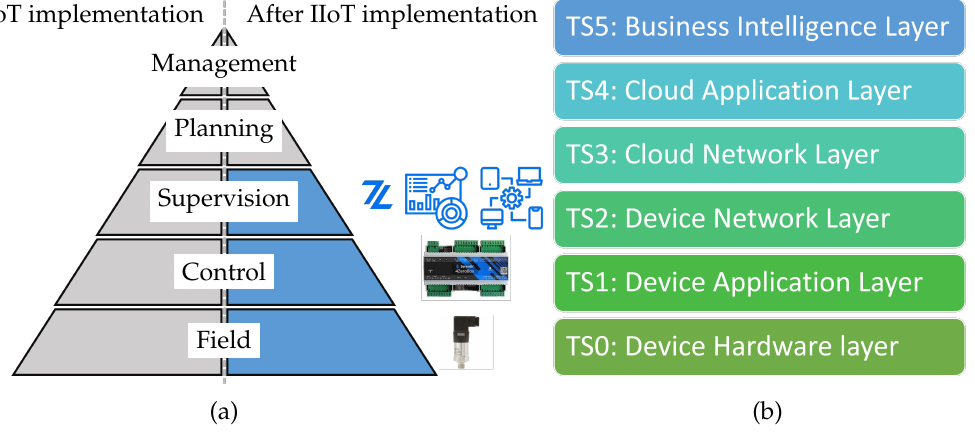
Figure 3. ( a ) Automation pyramid architecture used for ascertaining the current state of the factory and ( b ) IIoT stack used to present solution